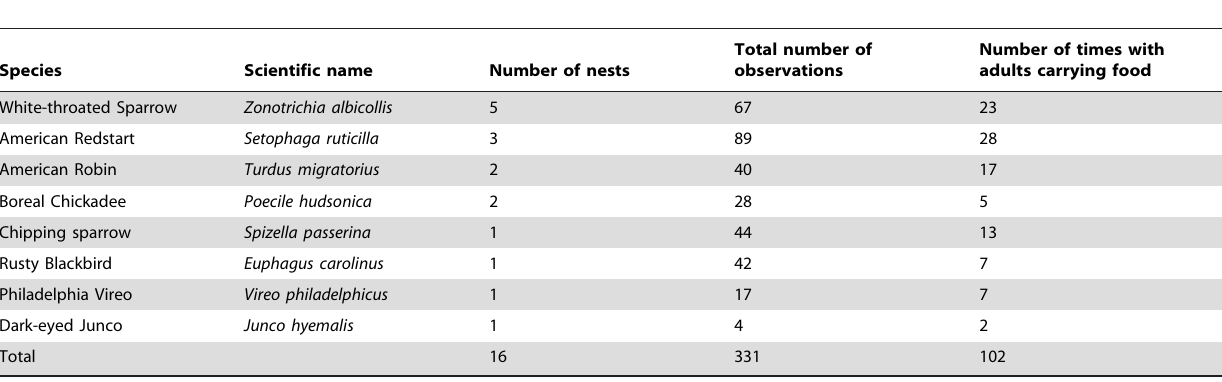
Table 2. Total number of monitored nests and observations for each species and number of cases where parental provisioning was observed during the breeding season in 2010 at Foreˆt Montmorency (Que´bec, Canada).